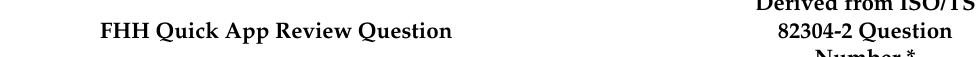
Table 1. FHH Quick App Review 25